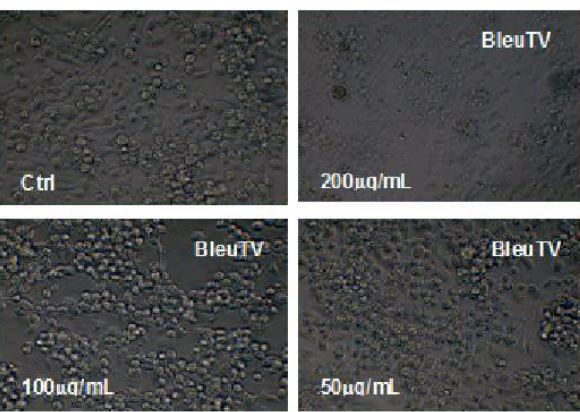
Figure 7. Morphological changes of murine macrophages after exposure to BleuTV. Ctrl: macrophages treated with PBS served as negative control. BleuTV: B. leucurus whole